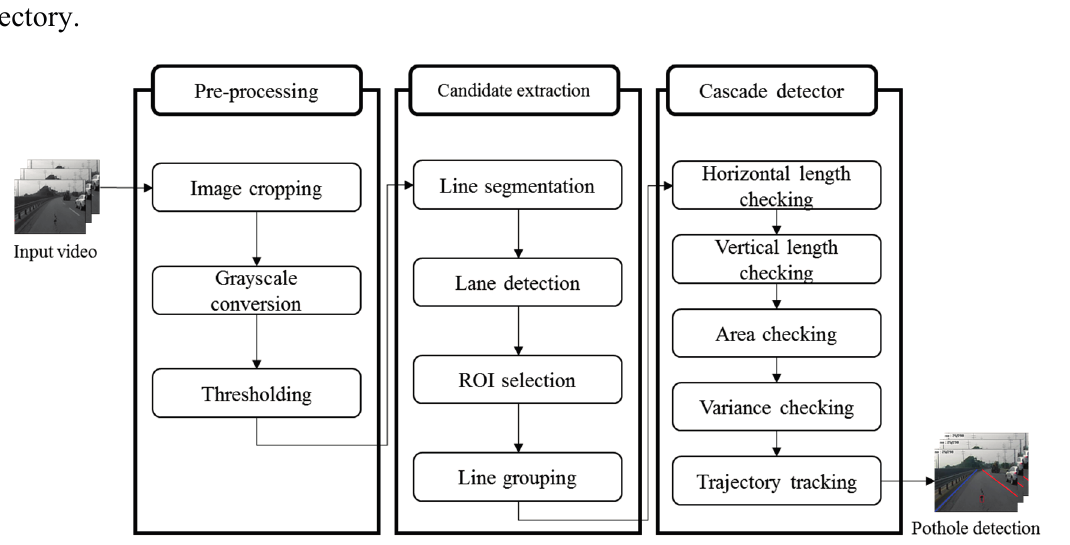
Figure 2. Proposed pothole-detection